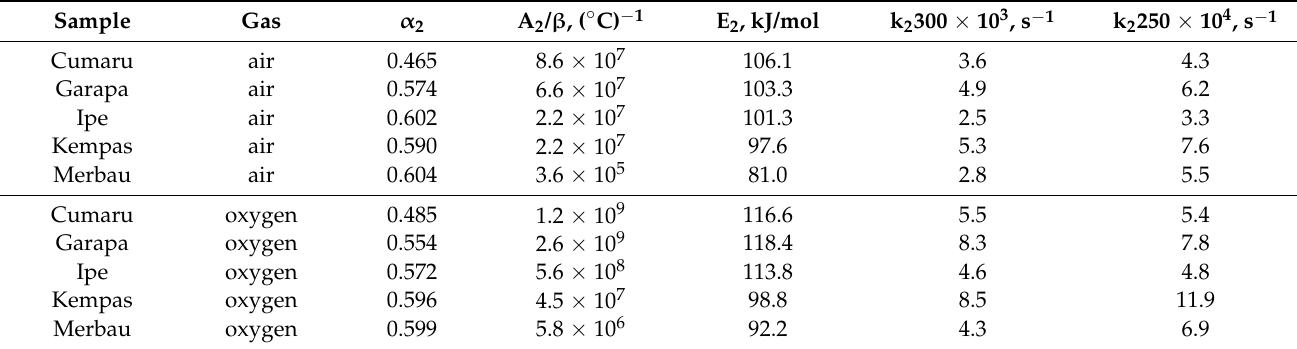
Table 2. Set of parameters extracted from deconvolution of non-isothermal thermogravimetry runs (the Equation (4), Table 1) for samples of tropical woods measured in air and oxygen decomposed with the rate of heating of 10 ◦ C/min. The above set of data is related to second component process (the red data) which was used for determination of the rate constants of second component of wood mass loss at 250 and 300 ◦ C.